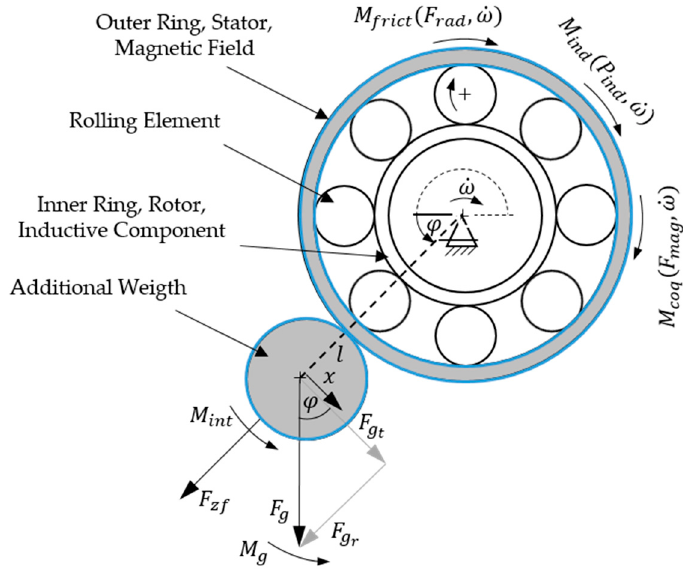
Figure 1. Operating principle, energy harvester components, torque distribution.